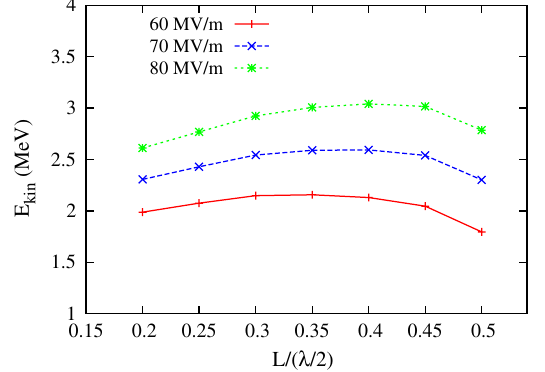
FIG. 9. Transverse emittance along the beam